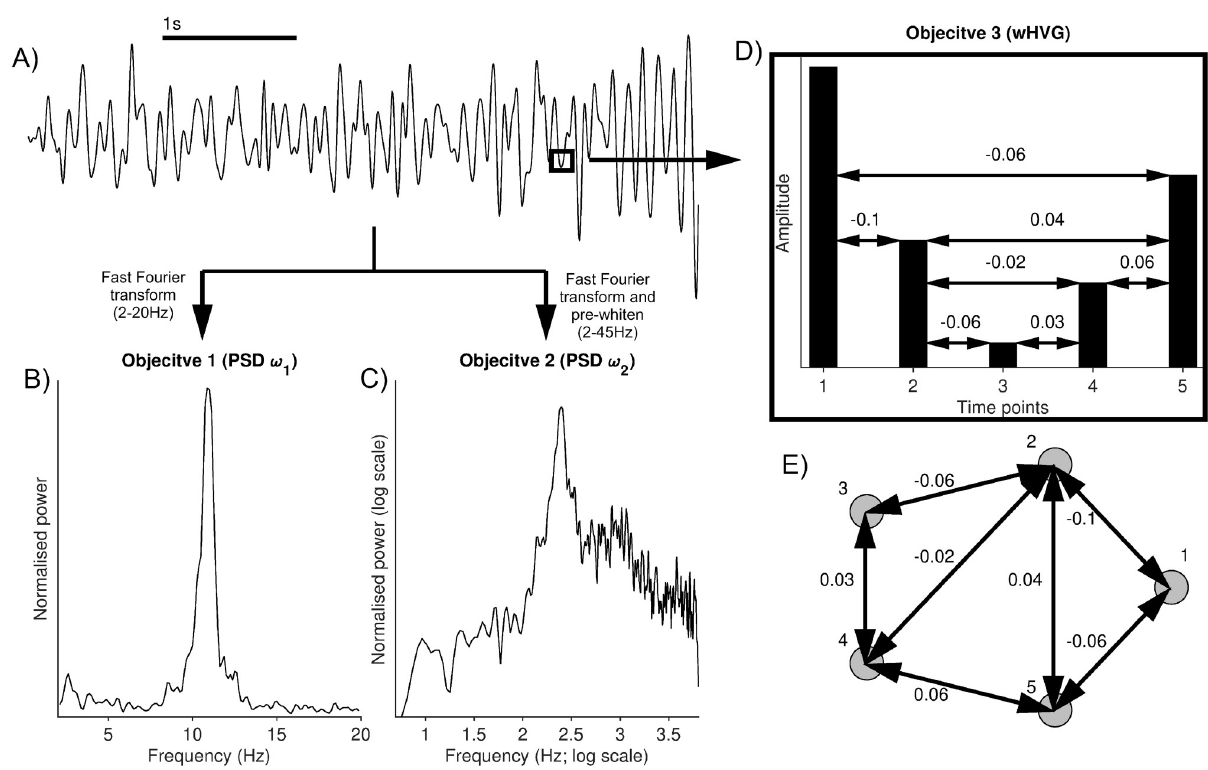
Fig 1. Illustration of the objective calculations used to compare model output to data. A) shows an exemplar z-scored EEG 5 s time series (note that the actual data used in this work are 20 s segments). A fast Fourier transform is applied to convert the time series into the frequency domain. B) shows the normalised power in the 2–20Hz range. This is used to calculate the objective for the SOEA20 and the first objective for the MOEA20. C) shows the normalised power after pre-whitening (see Methods). This is used to calculate the objective for the SOEA45 and the first objective for the MOEA45. D) shows the amplitude of 5 consecutive time points from the data in A), plotted as a bar chart. These time points have a resolution of 3.9 ms . The conversion of the time series into the wHVG distribution for this section of the time series is shown (note that the whole time series is used to calculate the wHVG distribution in practice). The resulting network from this transformation is given in E). The sum of node weights of the wHVG is then used in the calculation of the second objective for the MOEA20 and MOEA45